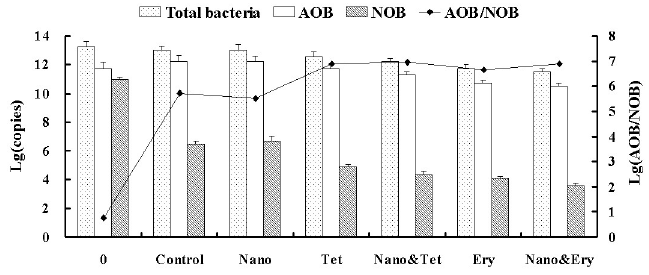
Fig 2. The count of AOB, NOB and total bacteria measured by